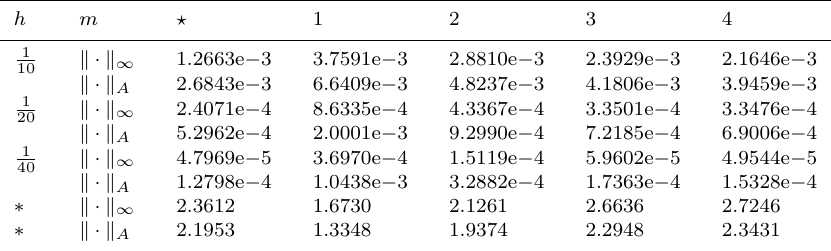
Table 3. Numerical results in the case a = 1 e −